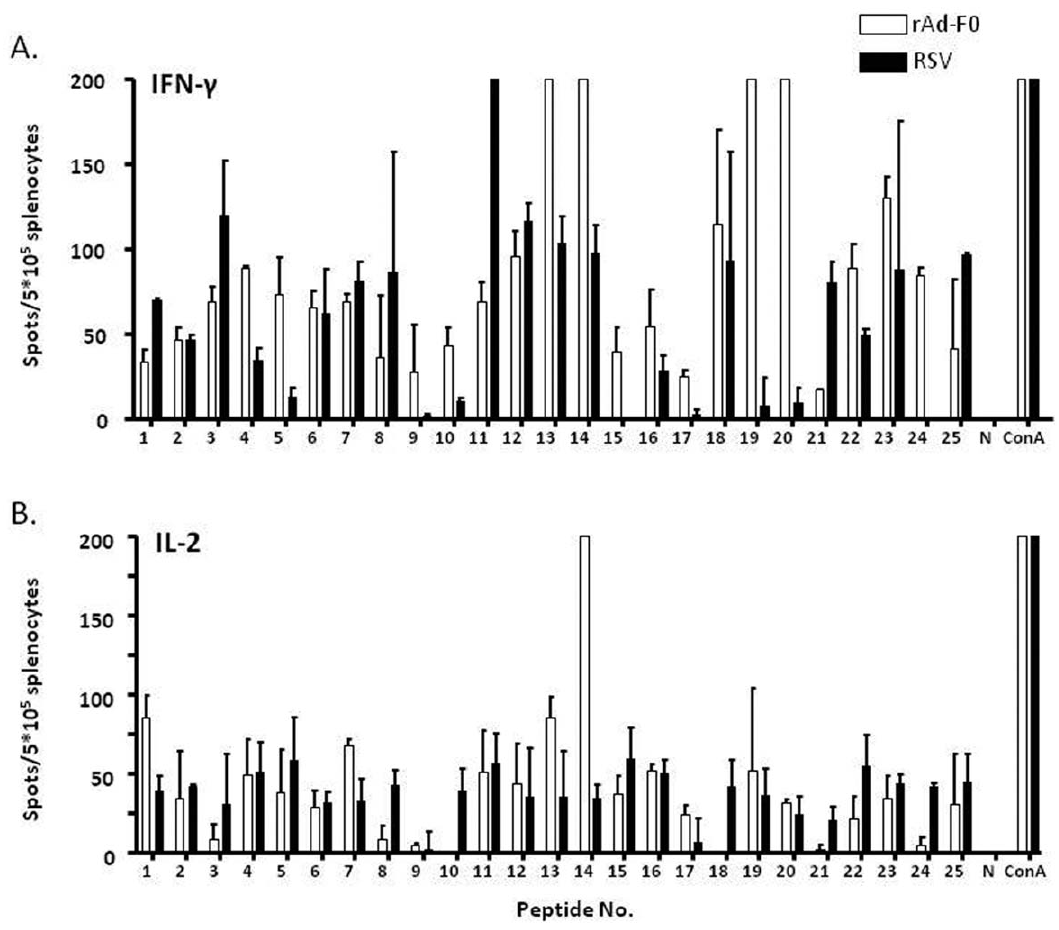
Figure 1. Induction of IFN- c and IL-2 in splenocytes from RSV F peptide immunized HLA-A*0201 transgenic mice upon secondary recall. Splenocytes harvested on day 30 from HLA-A-Tg B6 mice primed and boosted at 20 days interval intranasally with 10 7 pfu of rAd-F0 ( % ) or 10 4 pfu of RSV-B1 ( & )were restimulated with 2 m g of the individual RSV F peptide or 10 m g/ml Con A for 5 days in the presence of murine IL-2 . After stimulation, 5 6 10 5 splenocytes were seeded to anti-IFN- c (A) or anti-IL-2 (B) capture antibody coated ELISPOT plates for 2 days for ELISPOT assay as described in Materials and Methods. Cytokine-positive immunospots were developed and the results are expressed as the number of immunospots + / 2 2 standard deviations for each experimental group. Data is representative of results derived from two independent experiments, each with five mice per group.